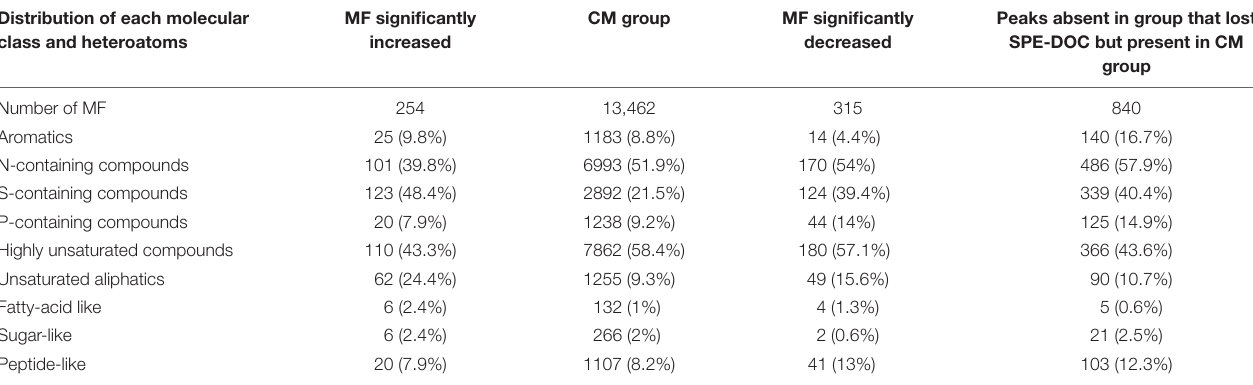
TABLE 3 | Comparison of molecular DOM composition showing the distribution of each class of molecules among the different classes of DOM for the molecular formulae (MF) that significantly increased between the group that gained SPE-DOC ( n = 6) and the conservative mixing group (CM group, n = 27), and the molecular formulae (MF) that significantly decreased between the group that lost SPE-DOC ( n = 6) and the conservative mixing group (CM group, n = 27). Distribution of each molecular MF significantly CM group MF significantly Peaks absent in group that lost class and heteroatoms increased decreased SPE-DOC but present in